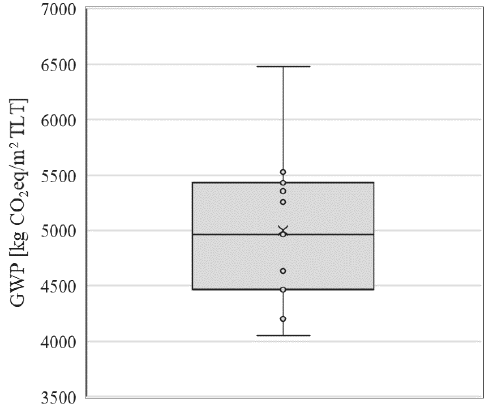
Figure 7. Statistical representation of the dataset.